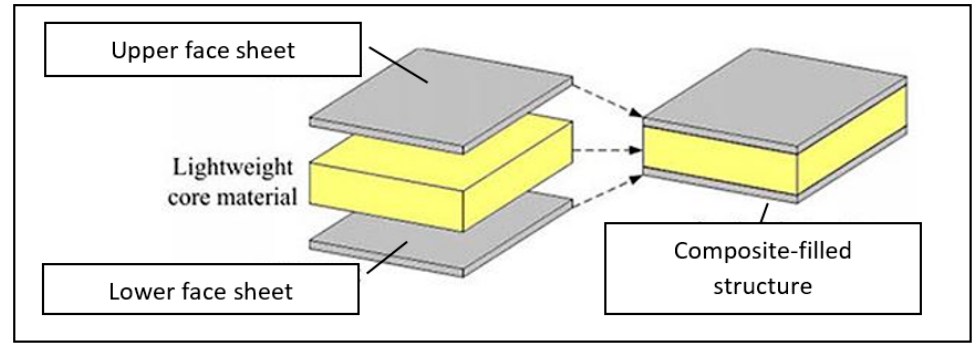
Figure 7. Sandwich composite structure layout.